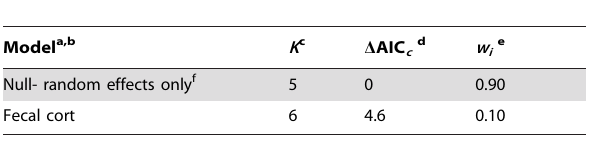
a Abbreviations of predictor variables in methods. b All models contain lek pairing and year as a random effect. c Number of parameters in the model. d Difference in AIC c (Akaike’s Information criteria for small sample size) values from the top ranking model. e Akaike